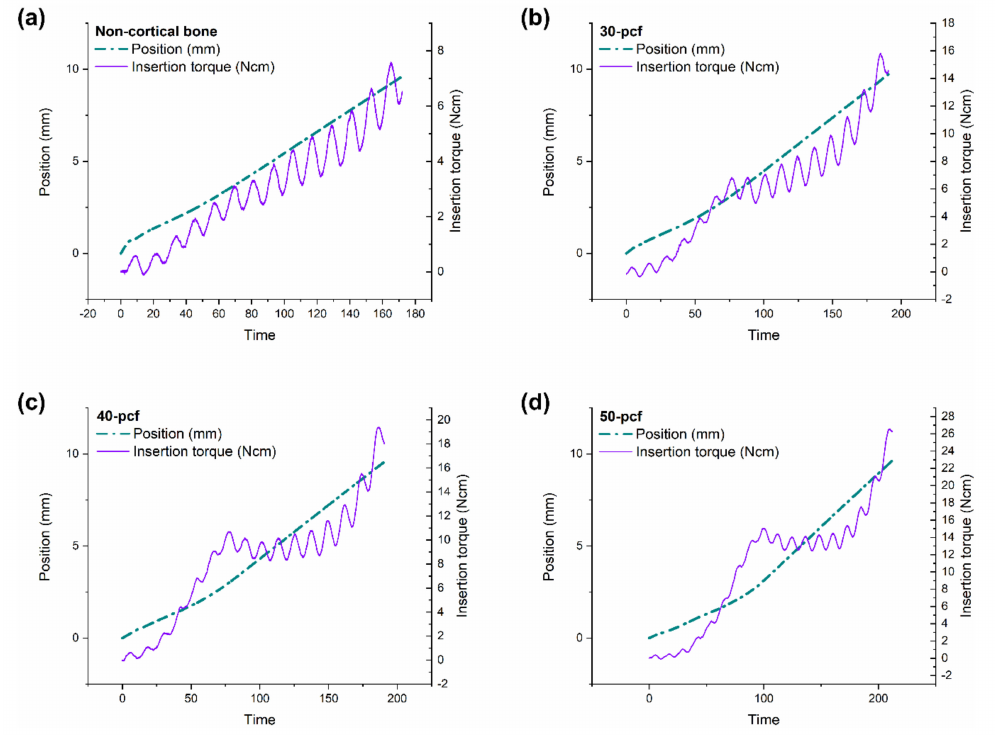
Figure 4. Position and torque values versus insertion time in ( a ) non-cortical bone, ( b ) 30, ( c ) 40, and ( d ) 50 pcf